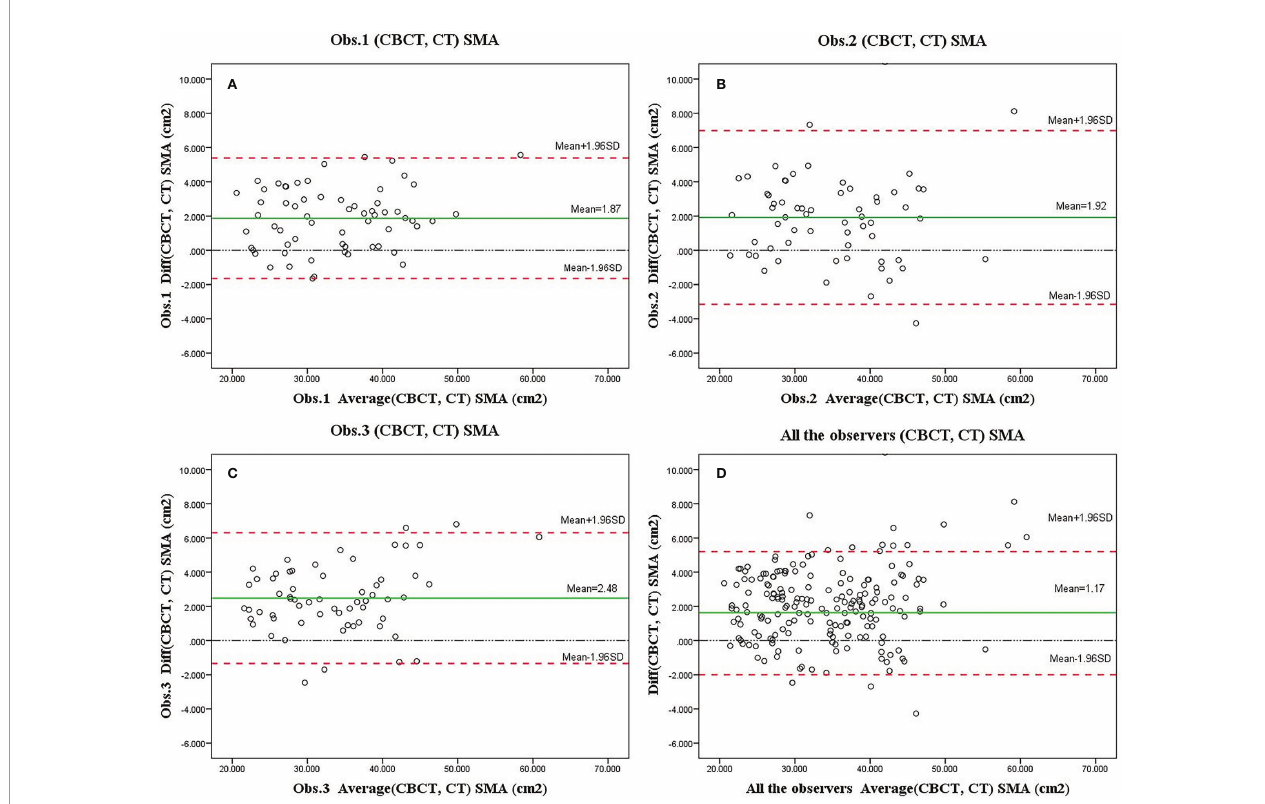
FIGURE 3 | Bland – Altman plots of skeletal muscle area (SMA) measurements at the level of C3 based on the cone-beam computed tomography (CBCT) and computed tomography (CT) scans as assessed by three observers (A – C , showed separately; D , showed altogether). Systematic bias estimates (mean, solid red line, and 95% limits of agreement) (mean difference ±1.96 standard deviation of the difference) are shown.